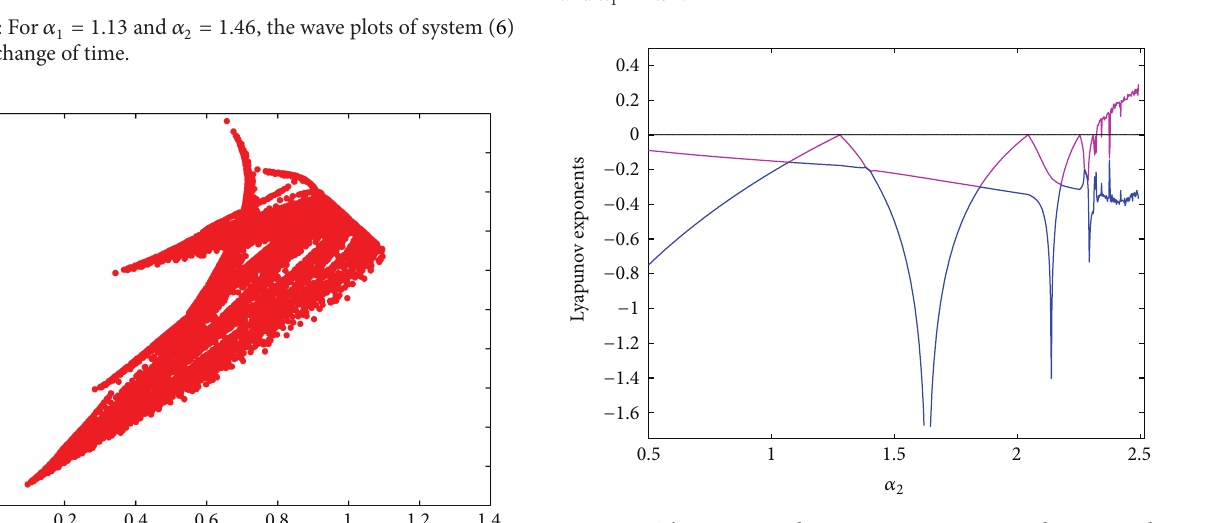
Figure 6: Bifurcation diagram of system (6) with 𝛼 2 ∈ (0.5, 2.51538] and 𝛼 1 = 1.32 .